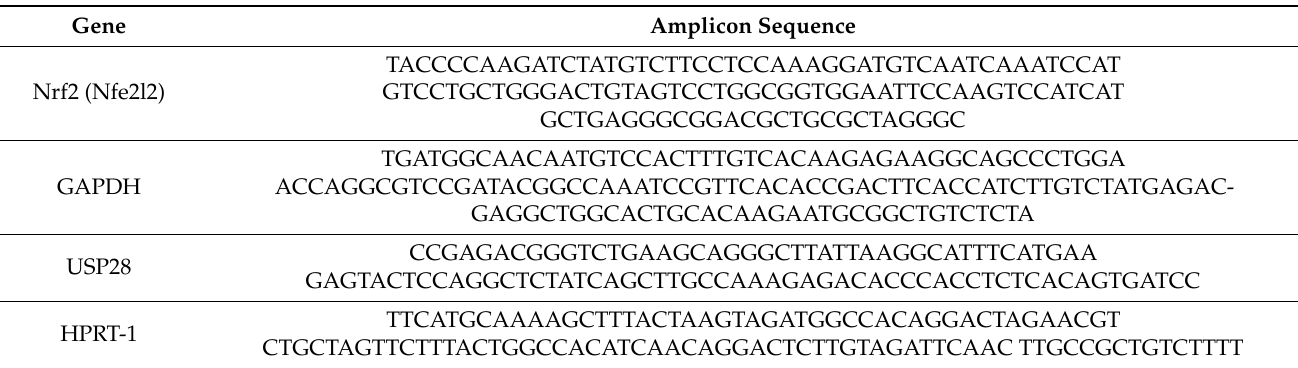
Table 1. Amplicon sequences of primers used in this study. Nuclear factor (erythroid-derived 2)-like 2 (Nrf2 or Nfe2l2) was the gene of interest to be analysed. Glyceraldehyde-3-Phosphate Dehydrogenase (GAPDH), Ubiquitin Specific Peptidase 28 (USP28), and Hypoxantine phosphoribosyltransferase-1 (HPRT-1) were used as reference genes. Gene Amplicon Sequence Nrf2